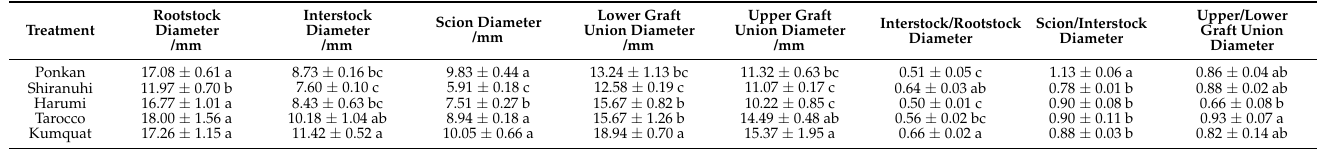
Table 2. Effects of different interstocks on vegetative growth.